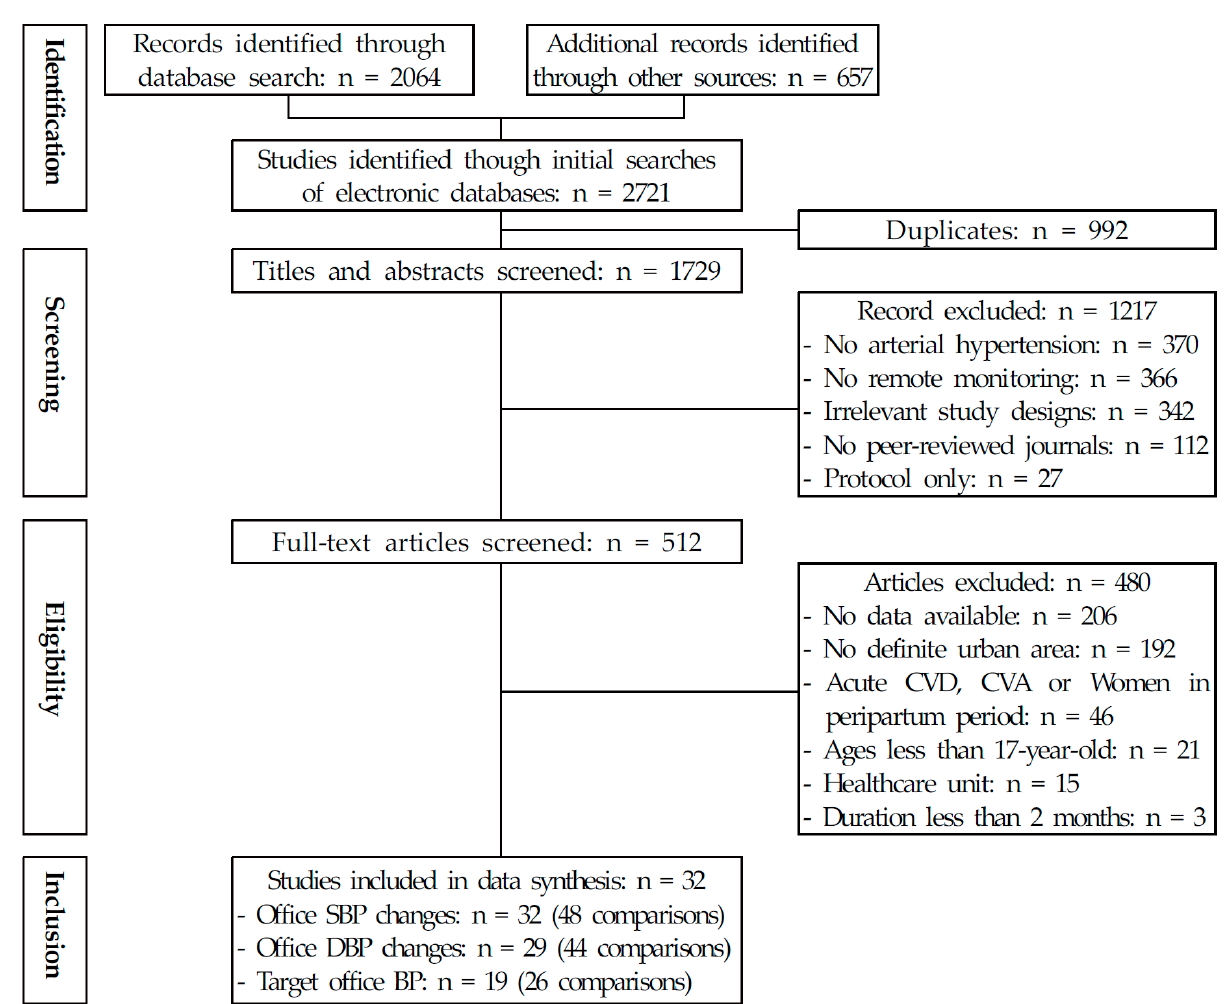
Figure 1. PRISMA flow of study. Abbreviations: BP, blood pressure; CVD, cardiovascular disease; CVA, cerebro-vascular accident; DBP, diastolic blood pressure; SBP, systolic blood pressure. Table 1. Characteristics of individual primary studies.